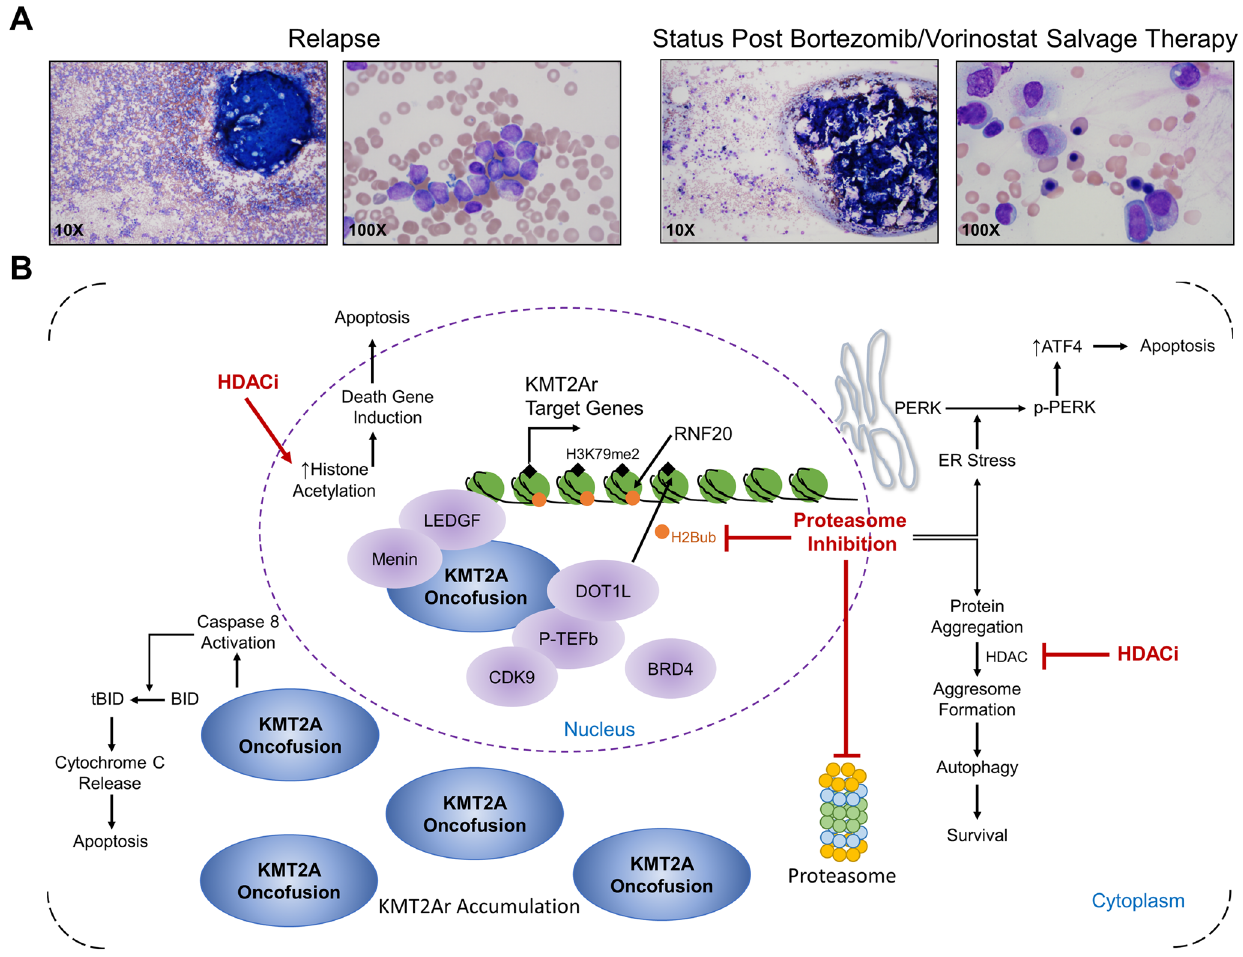
Fig. 5 | Restoration of trilineage hematopoiesis following treatment with bor- tezomib and vorinostat containing chemotherapy regimen in a refractory patient. A Bone marrow aspirates of case 3b (see Table 2) at the time of relapse post-transplant and post-treatment with bortezomib and vorinostat-containing chemotherapyregimenareshownat×10and×100magni fi cation.Flow-basedMRD and RT-PCR for the KMT2A-MLLT1 oncogene present in this patient were both